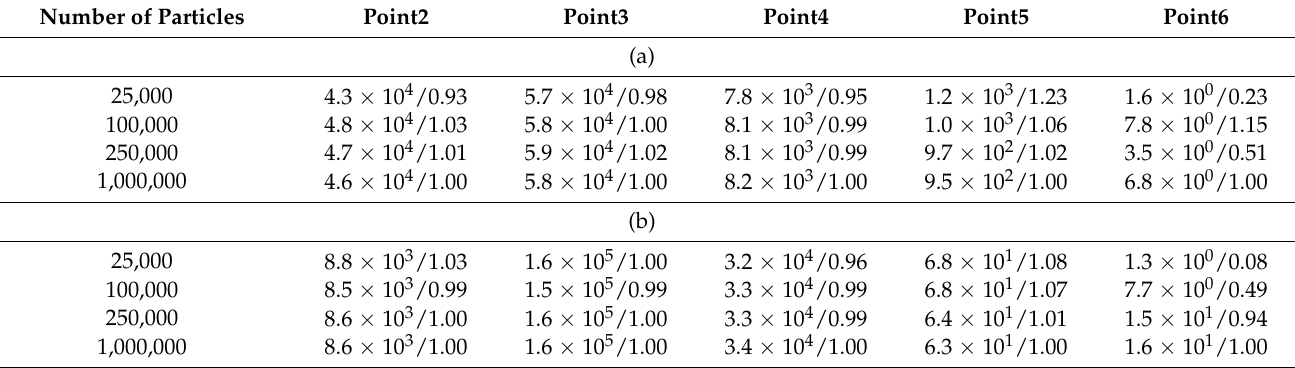
Figure 3. Trajectories, i.e., integrated paths, of the wind field for the initial point of the Bohunice NPP, at 10:00 UTC, 9 November 2020, for three various heights—100 m (blue line), 500 m (green line), and 1500 m (red line) above terrain. The locations of the six studied points are also shown. Table 3. Deposit of Cs-137, seven days from the beginning of the release of 1 × 10 15 Bq, in various points as a function of the number of particles modeled. (a) Dry deposit, [Bq/m 2 ], and ratio to dry deposit in the case of 1,000,000 particles; (b) Wet deposit, [Bq/m 2 ], and ratio to wet deposit in the case of 1,000,000 particles. Number of Particles Point2 Point3 Point4